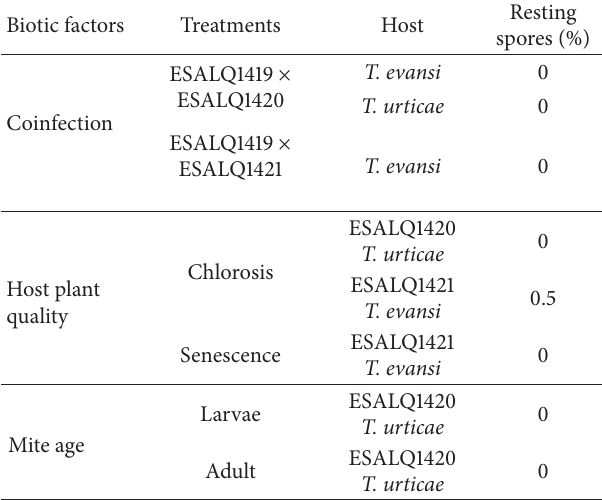
Table 3: Effect of different combinations of biotic factors, coinfec- tion, host plant quality, and mite age, on resting spores produced in N. floridana -killed T. urticae (Brazilian isolate: ESALQ1420) and T. evansi (Brazilian isolates: ESALQ1419 and ESALQ1421) isolates from